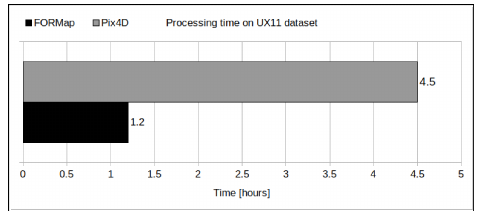
Table 3. Statistic on GCPs error processing by Pix4D and Figure 8. Reconstruction results of FORMap for the Highway FORMap on the UX11 and senseFly dataset. Measurement unit dataset. Left: 3D dense point cloud, right: is m .